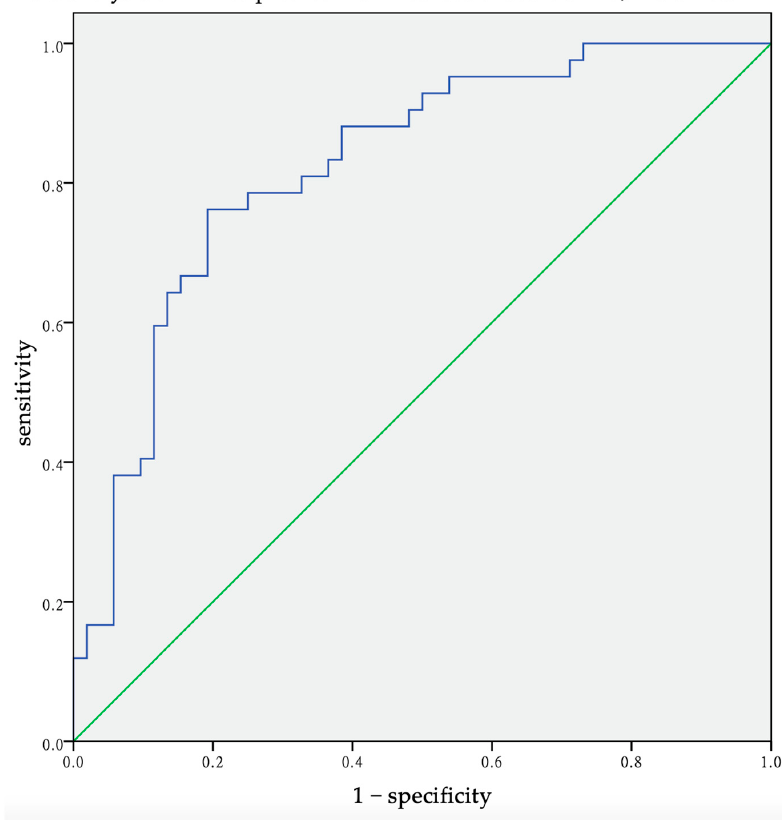
Figure 3. Receiver operating characteristic (ROC) analysis of the hypoperfusion index (HIR) to predict good collateral by multiphase CT angiography (mCTA) collateral score (4 or 5). The best predicted value of HIR was 0.68, with a sensitivity of 76%, specificity of 81% and area under curve (AUC) of